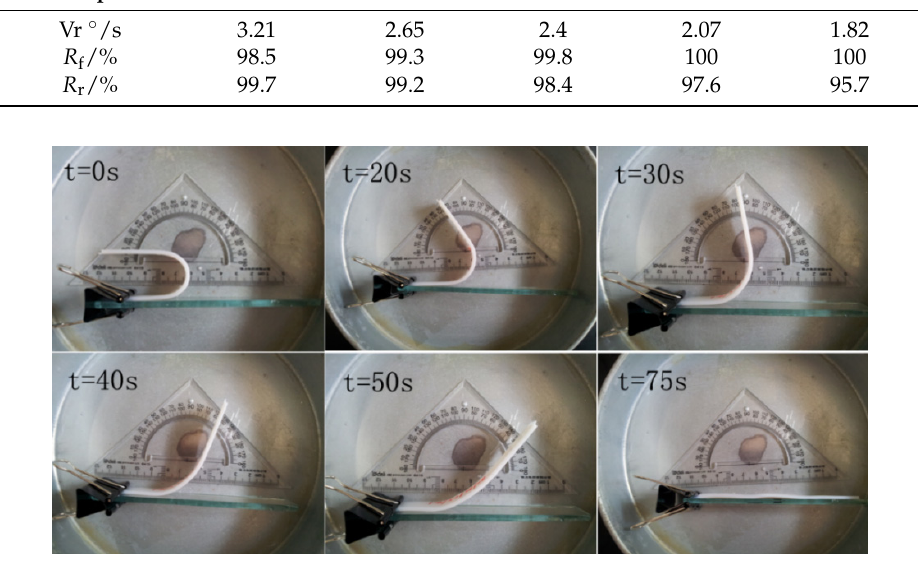
Figure 8. Shape memory process of the hydro-epoxy composites with 8 wt % SiCw at 56 °C.